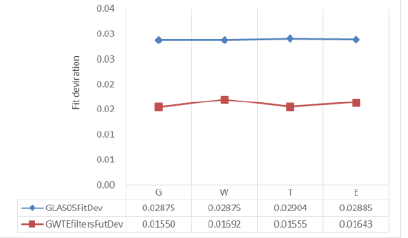
Fig.5 Fit deviation comparartion of different filiters and